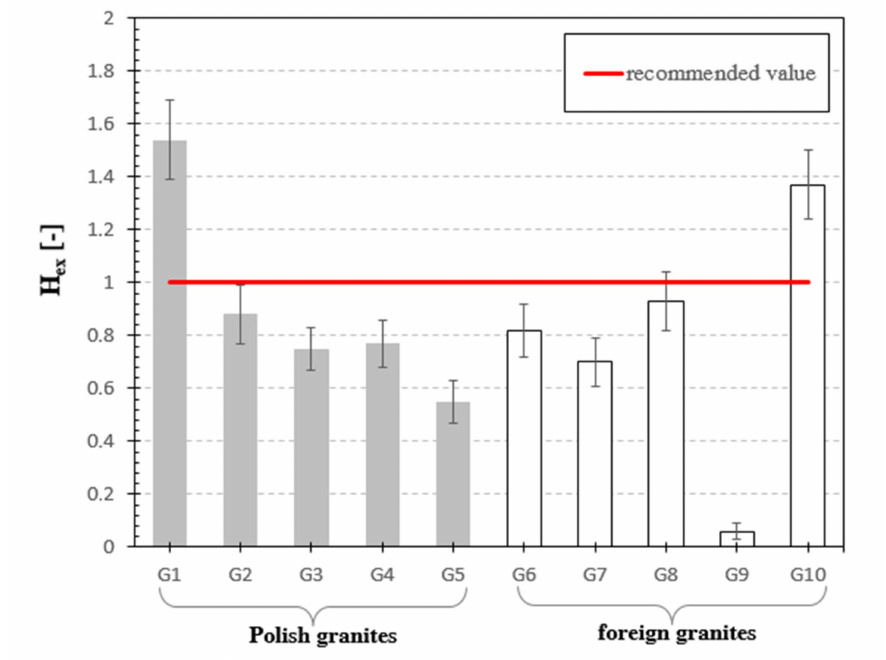
Figure 10. External Hazard Index for analyzed granite samples. The horizonal line indicates the recommended value of H ex equal to 1 [24] for natural